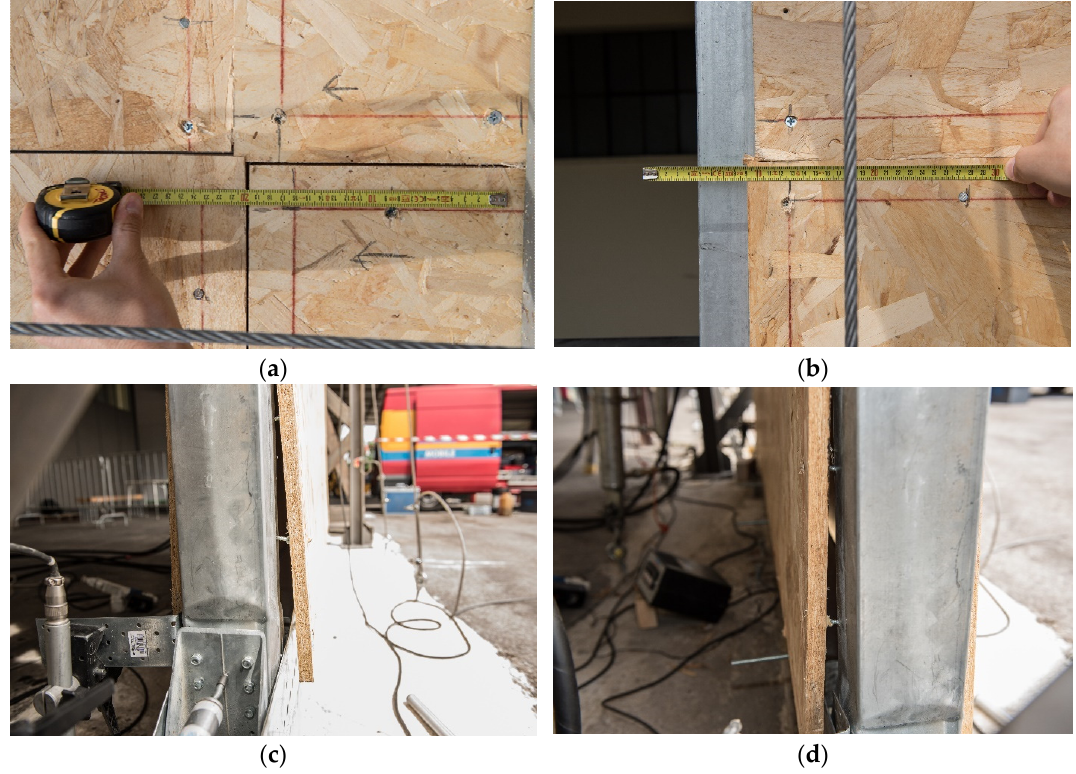
Figure 9. Details of failures evidenced in test: ( a , b ) relative slip between panels; ( c , d ) withdrawal of self-drilling screws and crushing of the steel column.